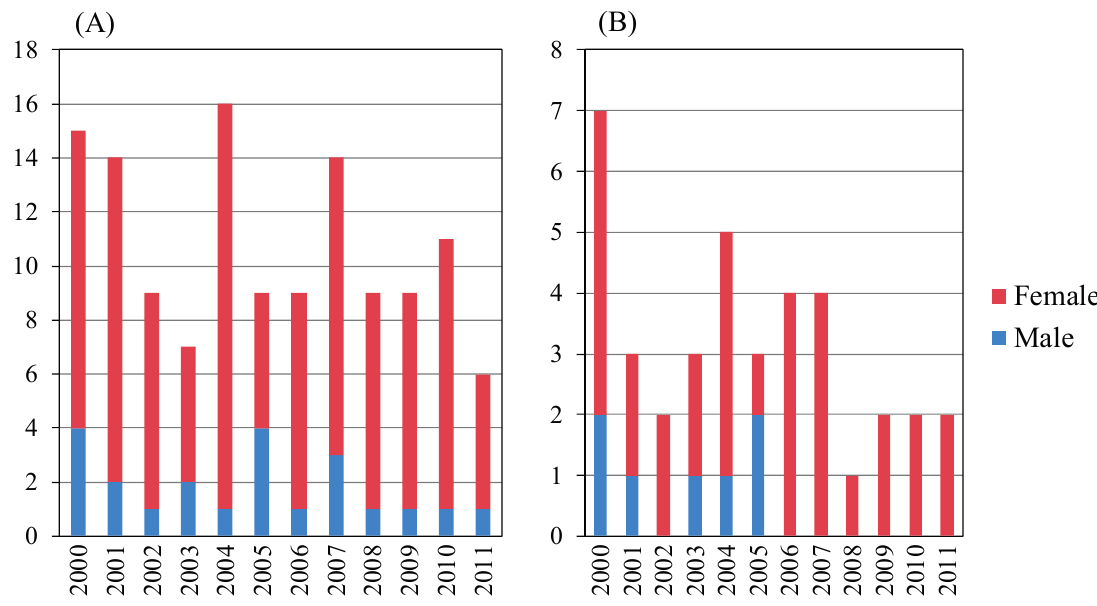
Figure 3. Annual numbers of autoimmune hepatitis patients with liver biopsy in the present study. ( A ) Total patients ( n = 128); male: female = 22:106; ( B ) Age ≥ 65 (years) ( n = 38), male: female = 7:31.